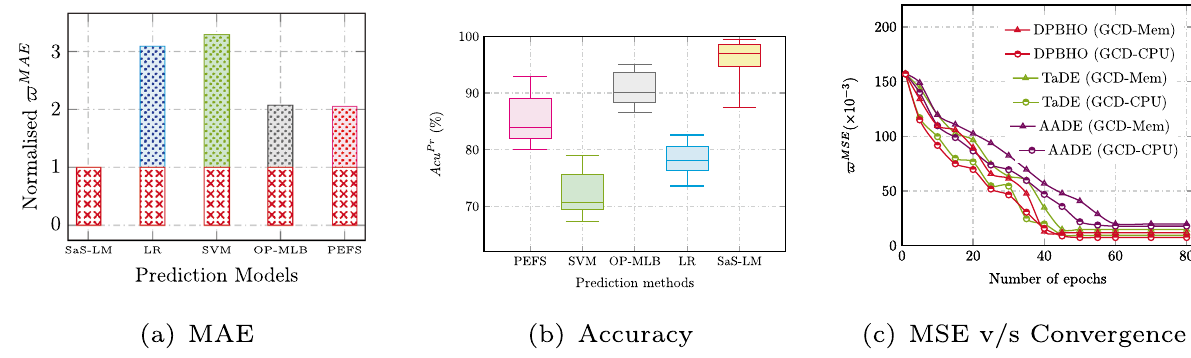
Figure 2. Prediction analysis.